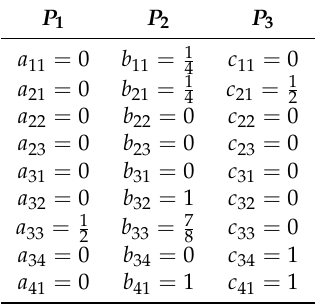
Table 3. Parameter values used for our second Nash equilibrium agent (NE2). The strategies fall at the “upper bound” of the space of “robust” Nash equilibrium strategies that receive the best worst-case payoff assuming the other agents follow one of the strategies given by the computed infinite equilibrium family. The values are for the free parameters in the infinite family of Nash equilibrium strategies. To define these parameters, a jk , b jk and c jk denote the action probabilities for players P 1 , P 2 and P 3 , respectively, when holding card j and taking an aggressive action (Bet (B) or Call (C)) in situation k , where the betting situations are defined in Table 2. P 1 P 2